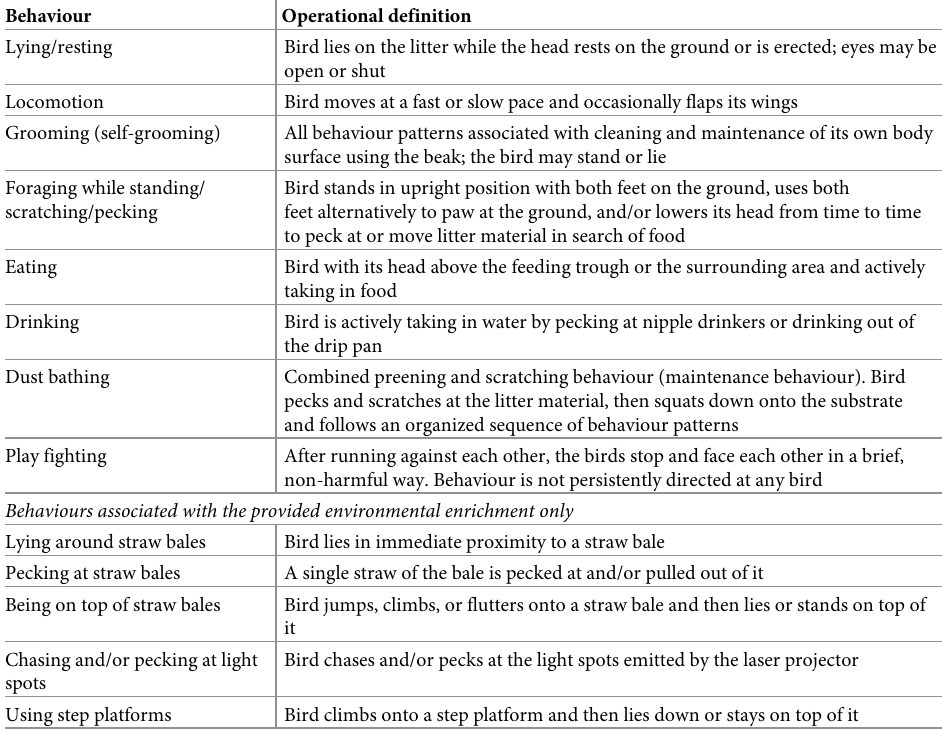
Table 1. Experimental ethogram. Behaviour Operational